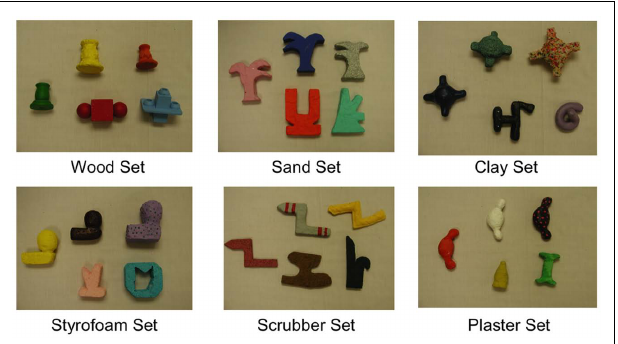
FIGURE 2 | Stimuli sets used in novel noun generalization. Each set is named after the material of its exemplar. In each display, the exemplar is to the far left, the two shape matches are on top, and the two material matches are on